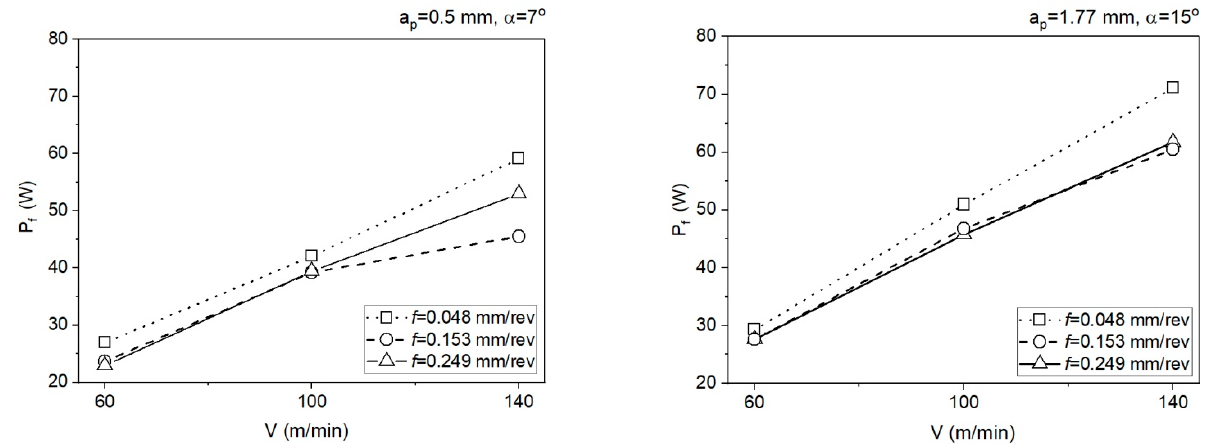
Figure 15. The friction power determined in the SSZ.